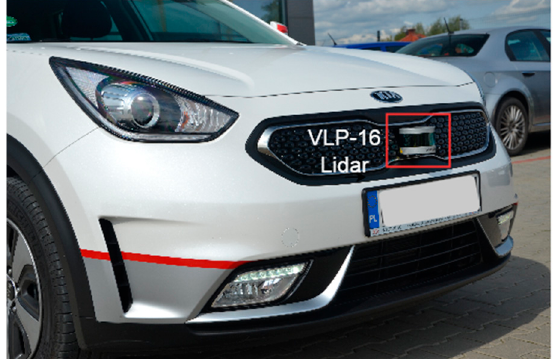
Figure 14. Velodyne VLP-16 lidar mounted at the front of a test vehicle. The vehicle is equipped with Nvidia AGX development system which analyzes data from the sensors.